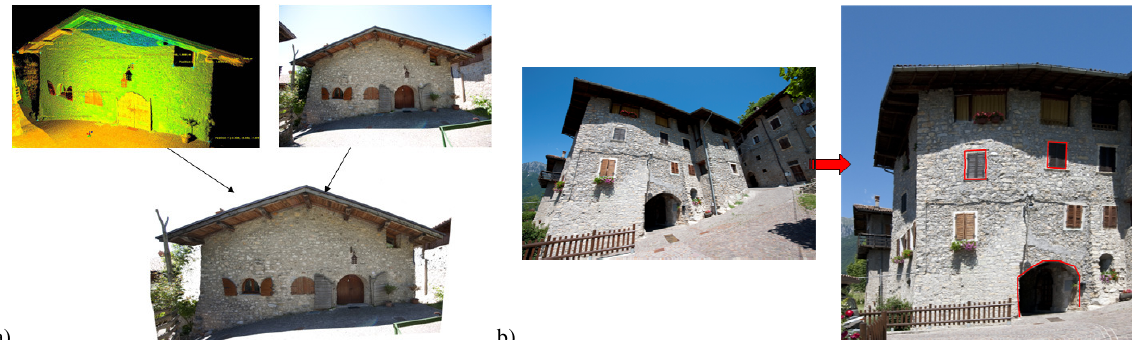
Figure 12: Range and image data co-registered to create an orthophoto of the façade (a). Produced orthophoto and vectorialization of architectural information (b).